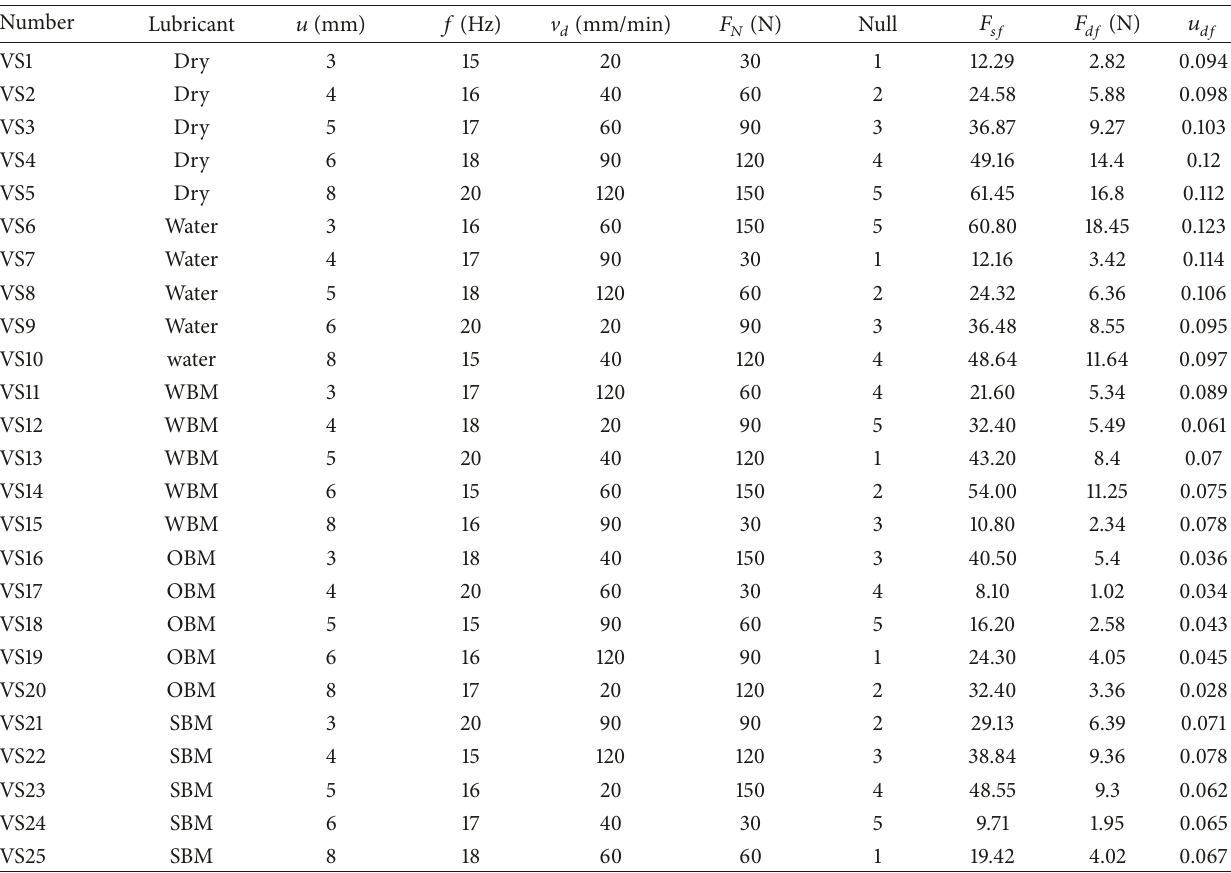
Table 4: Summary of experimental